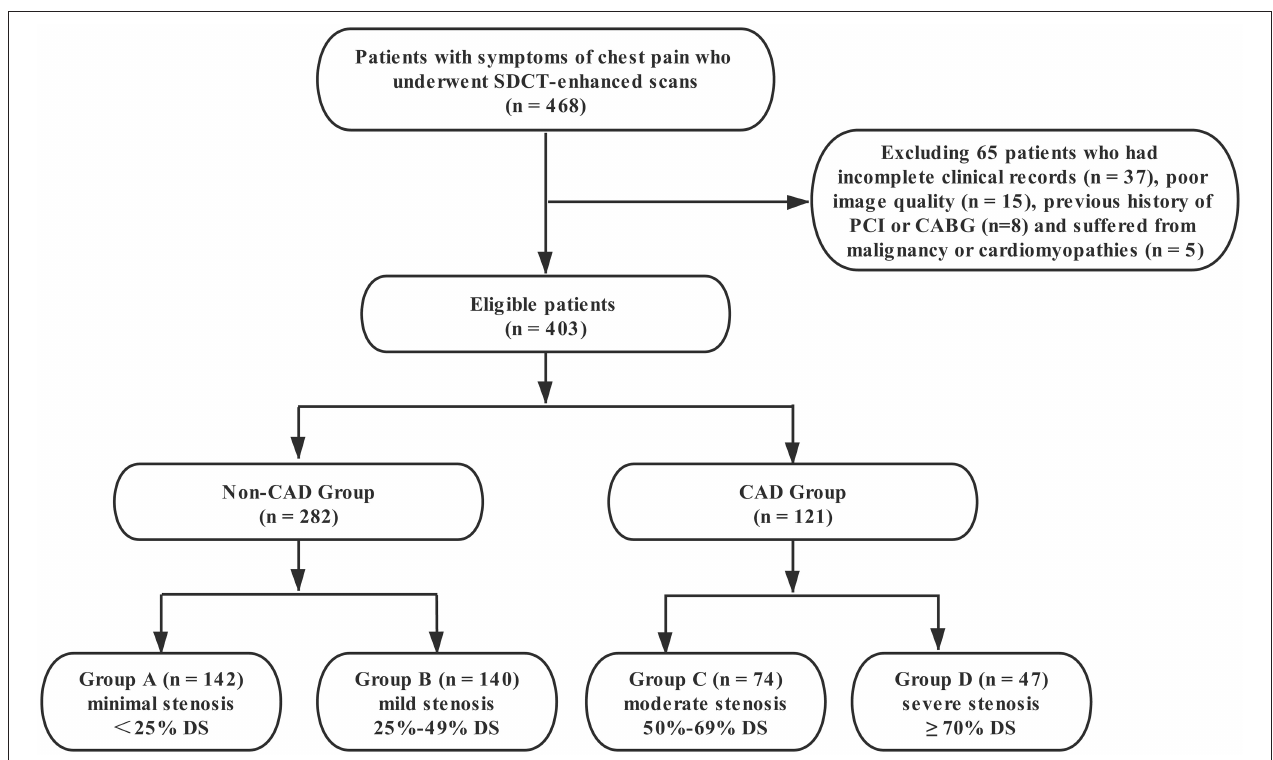
FIGURE 1 | Flow diagram of patient recruitment and grouping. PCI, percutaneous coronary intervention; CABG, coronary artery bypass graft; DS, diameter